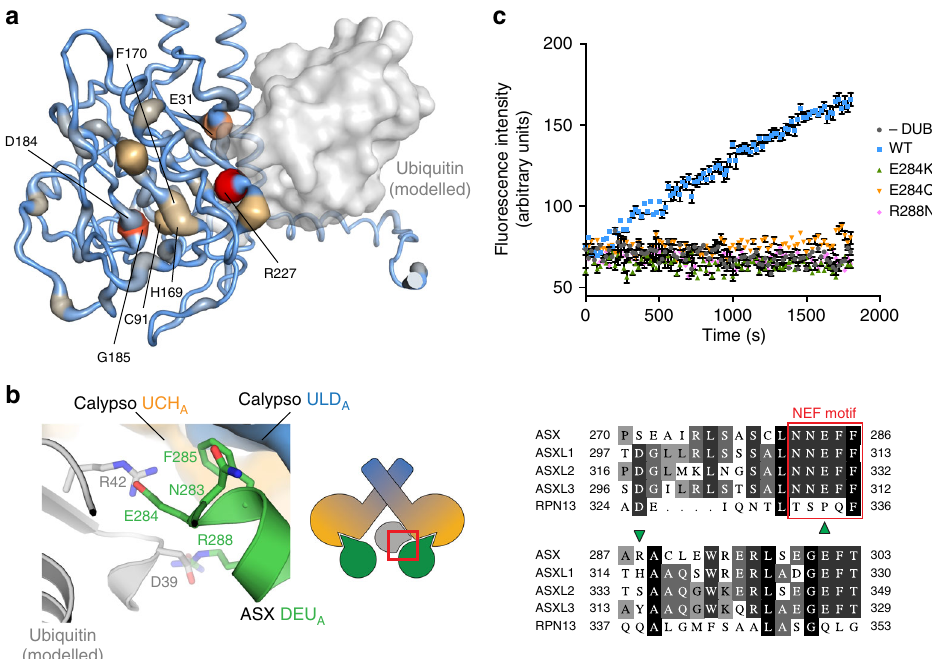
Fig. 2 Characteristics of missense mutations in the human PR-DUB. a Model of the Calypso~Ub – ASX complex generated as described in Fig. 1c, with tumour-derived missense mutations in BAP1 mapped onto the Calypso UCH domain. Residues mutated with low, medium, or high frequency are coloured blue, light orange, or red, respectively. Amino acids located in the active site cleft or at the ubiquitin interface are indicated (numbering refers to the BAP1 sequence; see Supplementary Table 2). The Deubad domain of ASX has been removed for clarity. b Close-up view showing the residues in the NEF- motif of ASX, including Arg288, and the putative interacting amino acids in the modelled ubiquitin (left). Multiple sequence alignment of the residues surrounding the NEF region in ASX, ASXL1, ASXL2, ASXL3, and of the corresponding residues in Rpn13 (right). The NEF-motif is highlighted with a red box; green arrows indicate the residues targeted for mutations. (see Supplementary Fig. 3a and Supplementary Table 3). c Ubiquitin-AMC hydrolysis assays comparing the activity of wild type and mutant Calypso – ASX complexes. Error bars indicate range of measurement ( n = 2 independent experiments). DUB, deubiquitinating enzyme; WT, wild type (see Supplementary Fig. 3b,